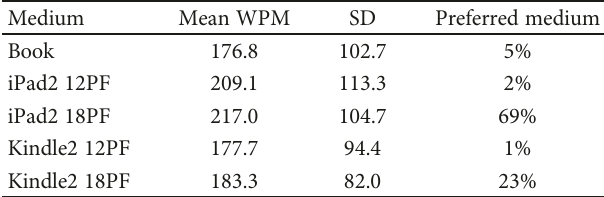
Table 1: Reading medium preferences and mean reading